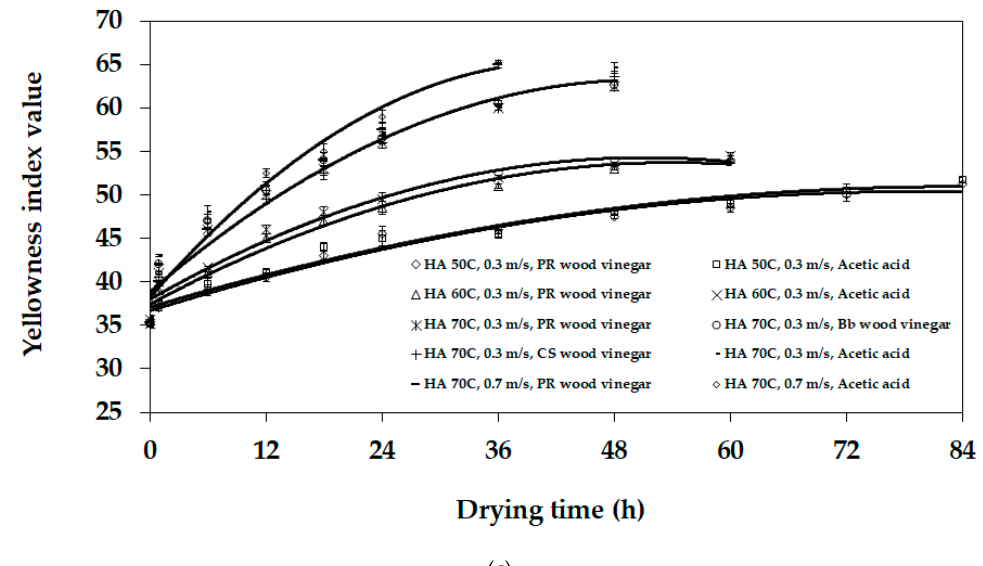
Figure 9. Comparison of predicted and experimental YI values: ( a ) zero-degree model; ( b ) first-degree model; and ( c ) second-degree model (HA = hot air, PR = para rubber, Bb = bamboo, and CS = coconut shell).